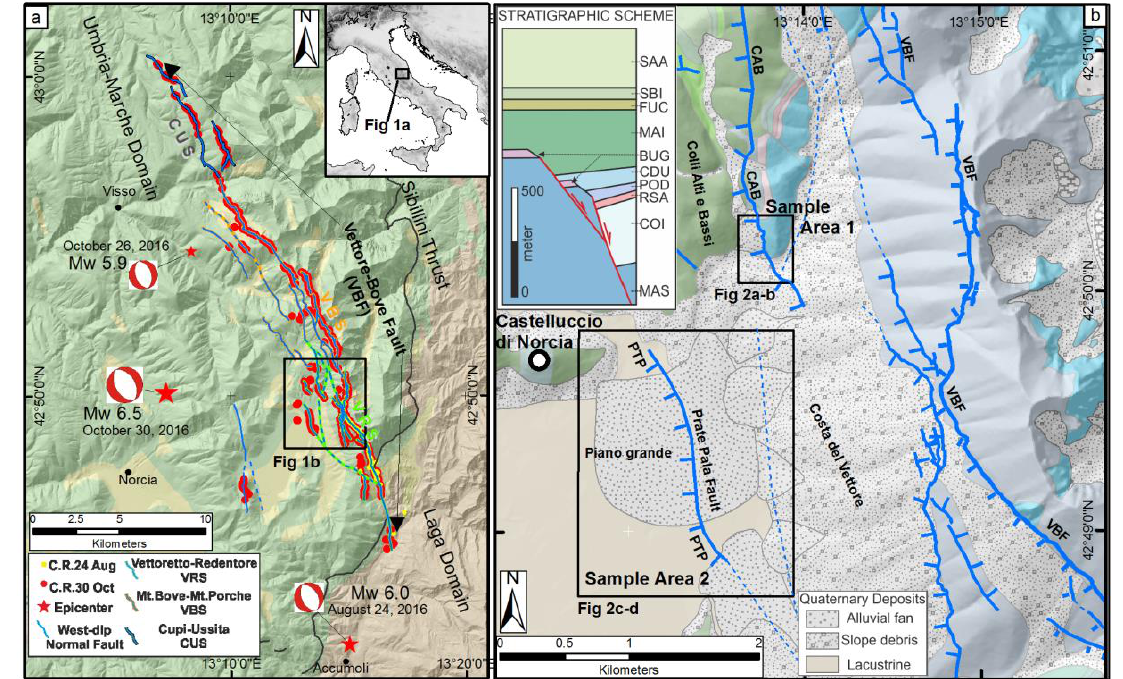
Figure 1. (( a )—top-right inset): location map of the study area in the central Apennines of Italy; (( a )—main figure) Structural sketch of the Mt Vettore-Mt Bove fault (VBF), with epicenters (red stars) and focal mechanism of the three M > 5.5 earthquakes of the 2016 seismic sequence, http: // terremoti.ingv.it / ; Geological key color—green: Umbria-Marche Domain, brown: Laga Domain, yellow: Quaternary deposits; ( b ) Geological map of the study area, after Pierantoni et al. [29], modified, and location map of the two sample areas (1 and 2) where the Colli Alti e Bassi (CAB) and e Prate Pala (PTP) splays of the VBF crop out; top-left inset shows the stratigraphic scheme of the area extracted from Pierantoni et al. [29]; MAS: Calcare Massiccio; BUG: Bugarone Group; COI: Corniola; RSA: Rosso Ammonitico; POD: Calcari a Posidonia; CDU: Calcari Diasprigni; MAI: Maiolica; FUC: Marne Fucoidi; SBI: Scaglia Bianca; SAA: Scaglia Rossa .